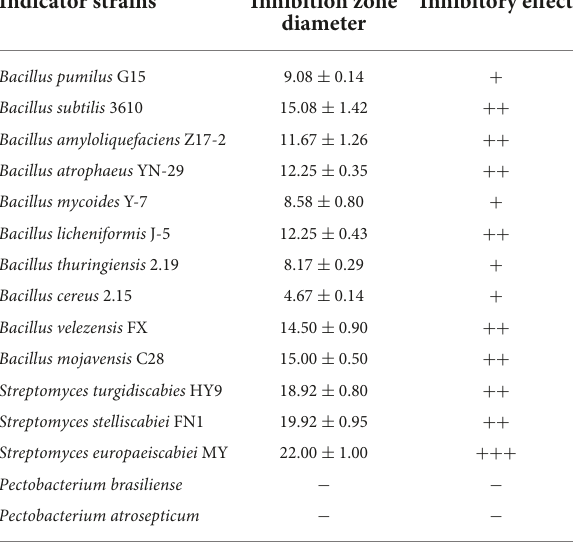
TABLE 2 Antibacterial activity of Lcn972 against bacteria. Indicator strains Inhibition zone